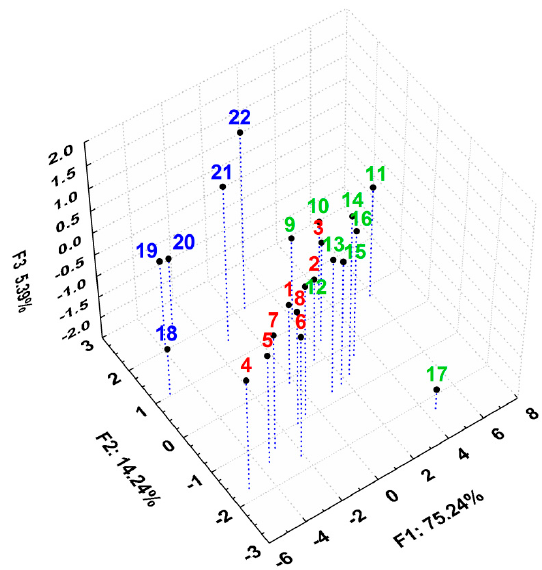
Figure 6. 3D plot of the scores for first three principal components after applying PCA on all the discussed parameters, describing lipophilicity for all the studied compounds.